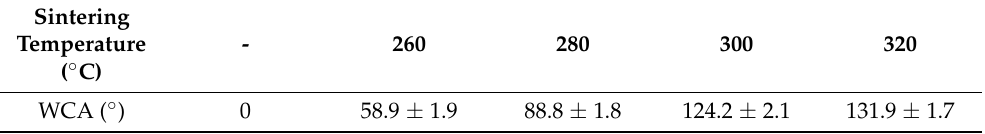
Table 2. The data of water contact angle (n = 5).